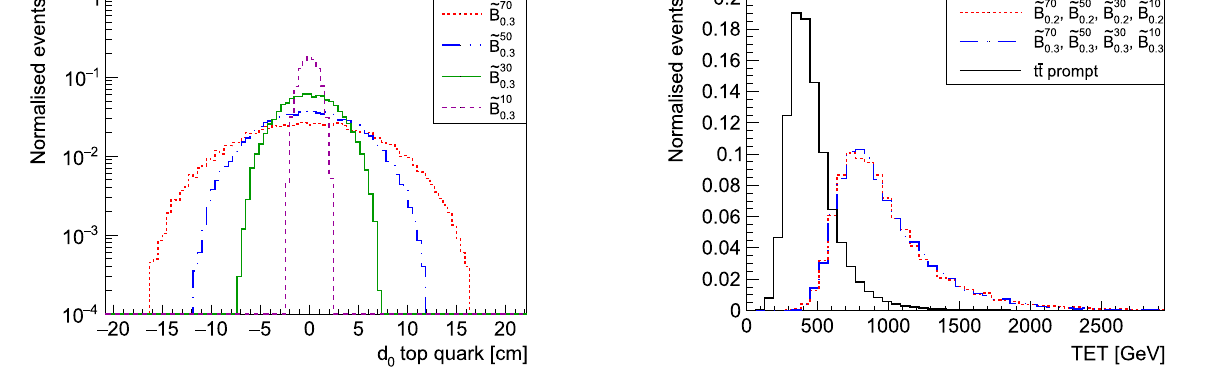
Fig. 18 Total transverse energy TET in the ˜ B -like case